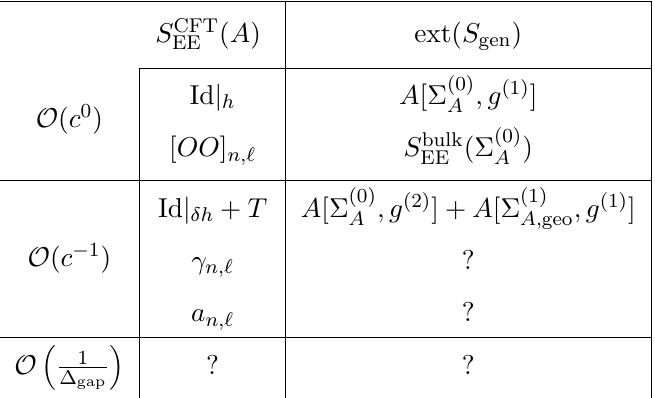
Table 1 . The dictionary between CFT OPE data and the contributions to the generalized entropy of the quantum extremal surface. The terms in the ext( S left over after the various cancellations between bulk